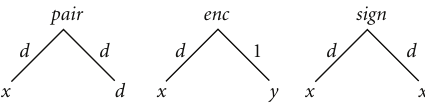
Figure 3: Safe costs